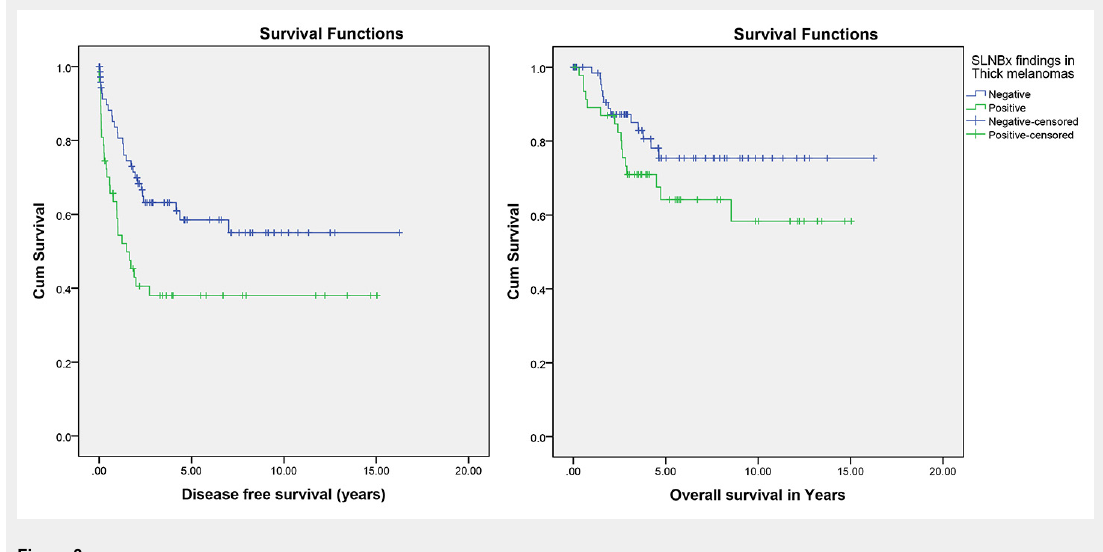
Figure 3 Effect of sentinel lymph node biopsy (SLNBx) result on disease-free and overall survival in thick melanoma (p = 0.008 and p = 0.13,